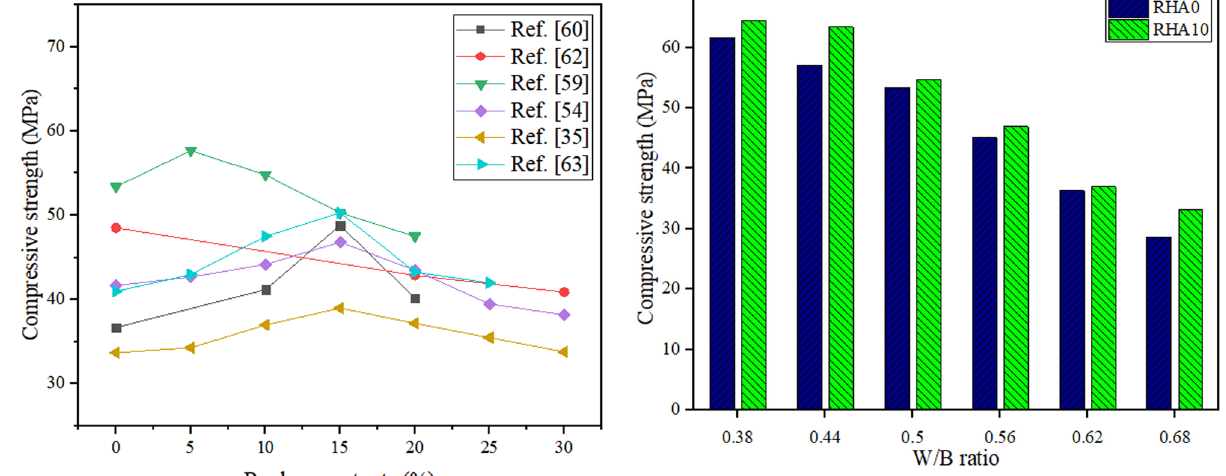
Figure 7: E ff ect of W/B ratio on compressive strength of RHA – SCC [ 59 ]